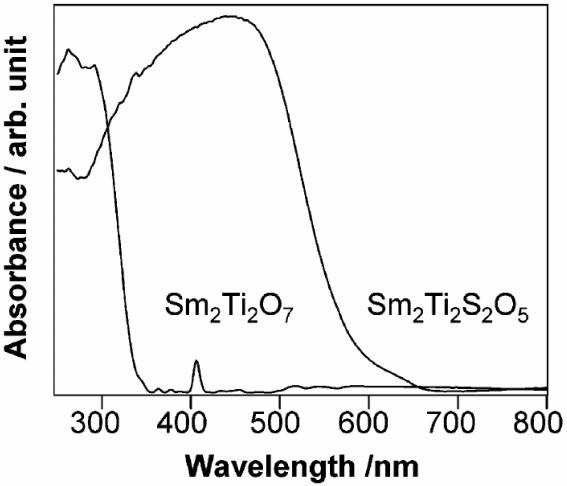
Figure 9. UV-Vis diffuse reflectance spectra for Sm 2 Ti 2 O 7 and Sm 2 Ti 2 S 2 O 5 . Reproduced with permission from [143]. Copyright American Chemical Society,